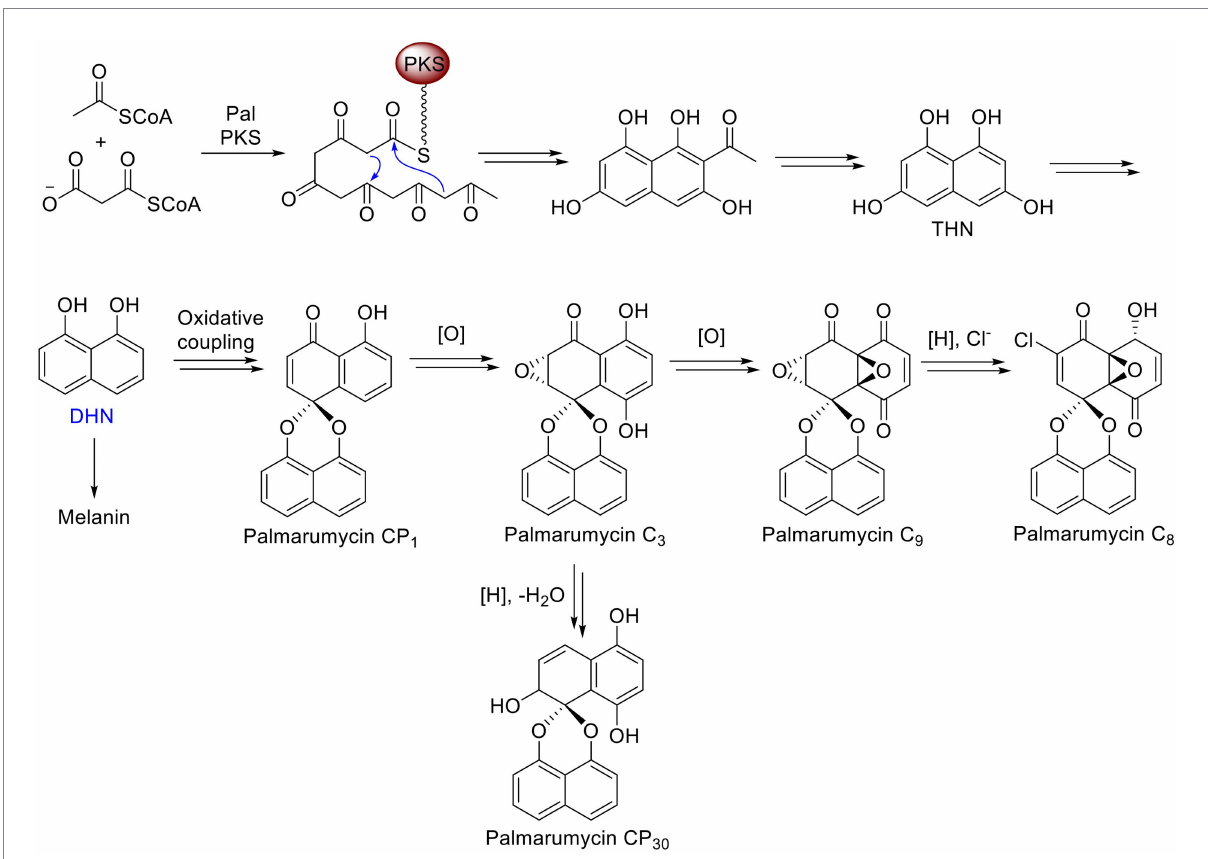
FIGURE 7 Proposed biosynthetic routes to melanin, palmarumycin C 8 , and palmarumycin CP 30 from their shared precursor DHN in Lophiotrema sp.